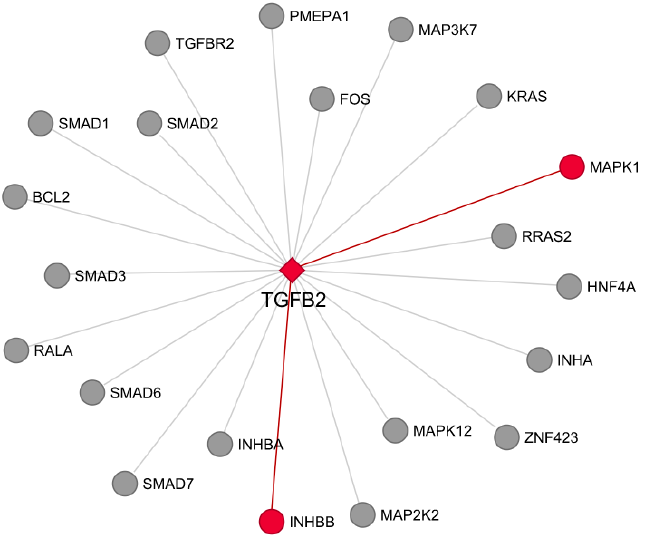
Figure 5. TGF β signaling pathway network. Genes included are from the IPA canonical pathway, and all of them are in differentially accessible regions (DARs) in weaning. Red edges represent significant co-expressed genes (>0.8) using RNA-seq data. The TGF β 2 was selected as the hub gene for the network.